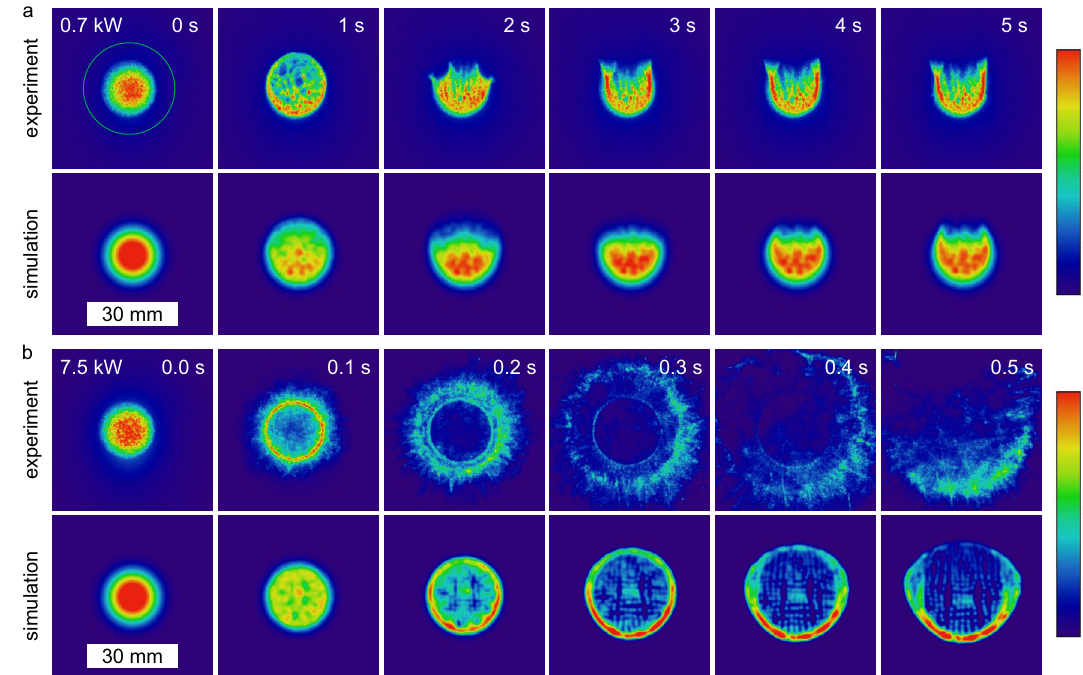
Figure 2. Intensity distribution (colorbar on the right, logarithmic scale, arb. u.) of a laser spot ( D 4 σ = 17.8 mm , input power 0.7 kW ( a ) and 7.5 kW ( b ), continuous wave) after passing 10.1 cm water determined by experiments and simulations. For the lower input power, first a size increase and then an opening towards the top is observed. The green circle indicates the aperture size of the used power meter. For the high input power, a much faster change over a ring pattern to a fast changing and irregular large pattern is observed. Phenomenologically, there is a good agreement between the experimental and simulated results, considering that in the simulation the change of the refractive index was not taken into account for the energy deposition (see text for